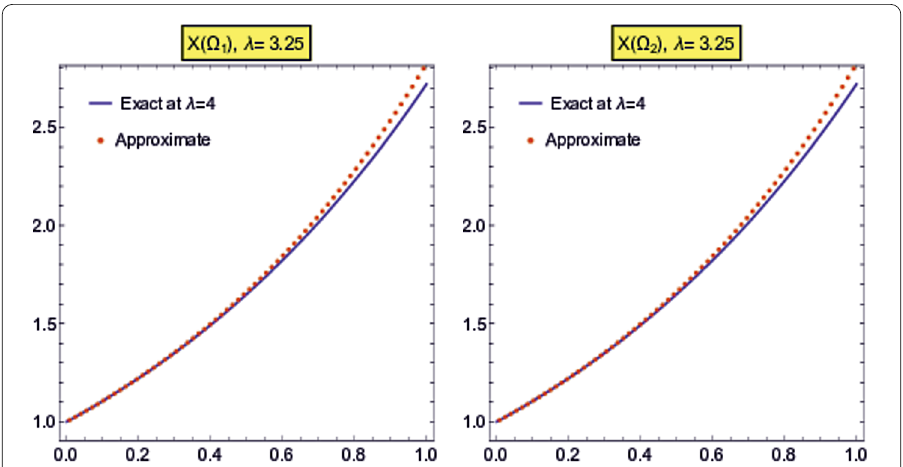
Figure 2 Comparison of the exact and approximate solutions of Example 4.1 for m = 3 and λ = 3.25